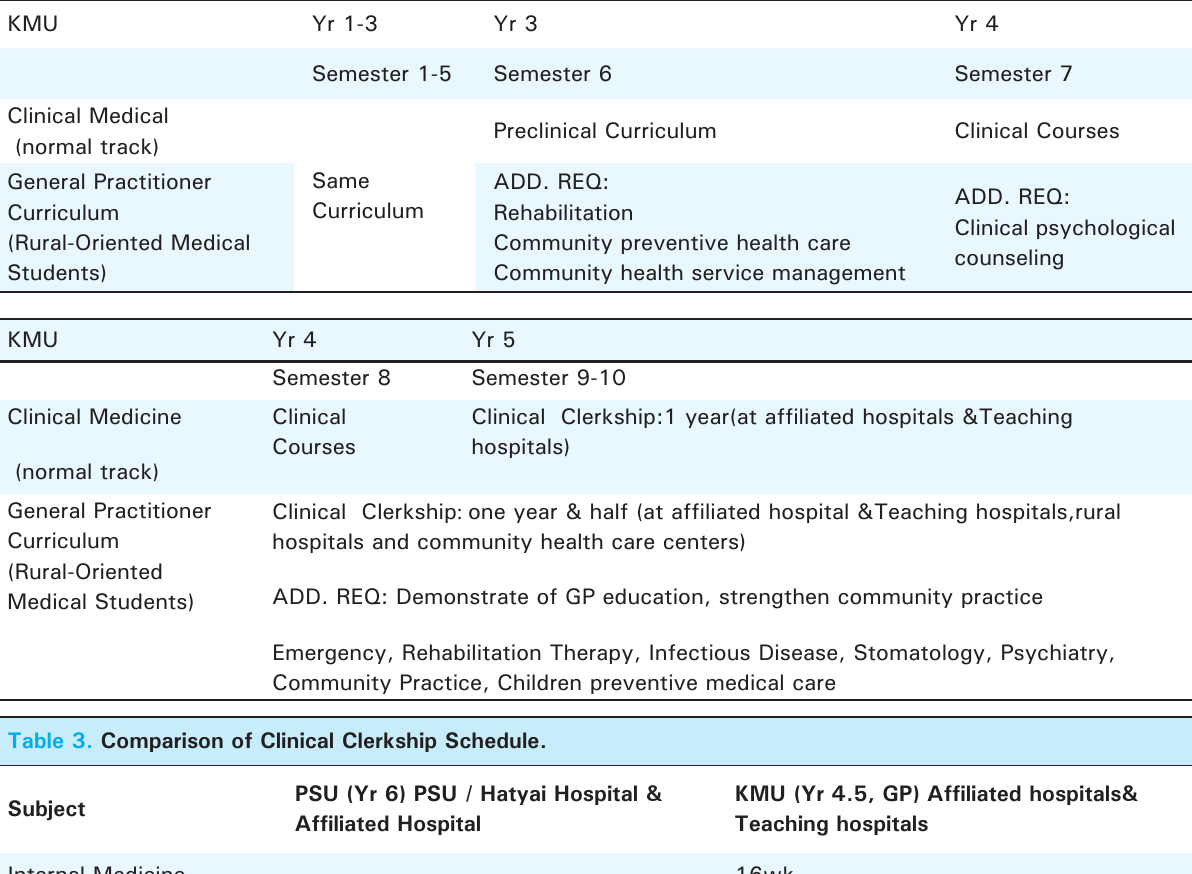
Table 2. Curriculum Comparison between Rural-Oriented Medical Students and Normal Track.